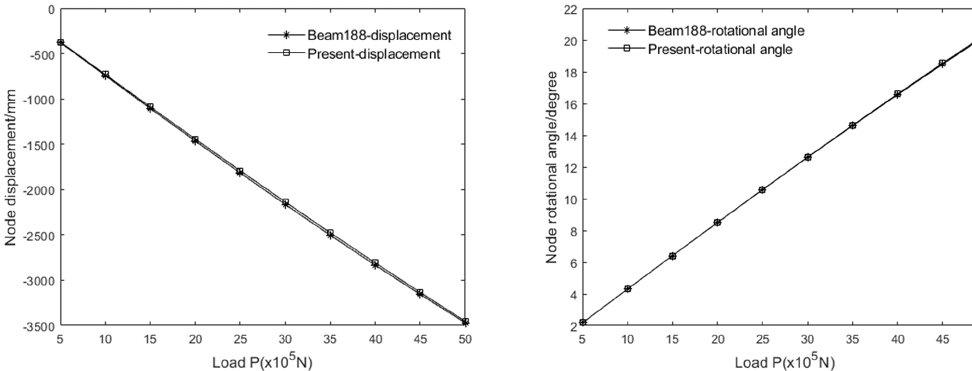
Figure 14. Force–displacement relationship of the right end section.